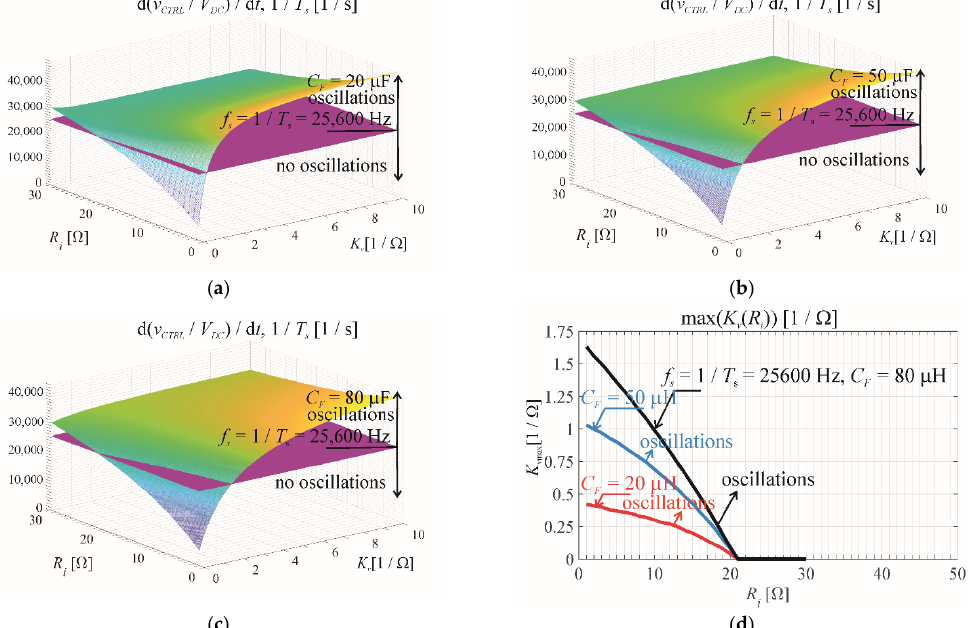
Figure 4. Determining the border gains ( d ) of the IPBC controller at different capacitances C F (20 ( a ), 50 ( b ), and 80 μ F ( c )), for L F = 1 mH, R LF = 1 Ω , M = 0.5, and f s = 25,600 Hz.